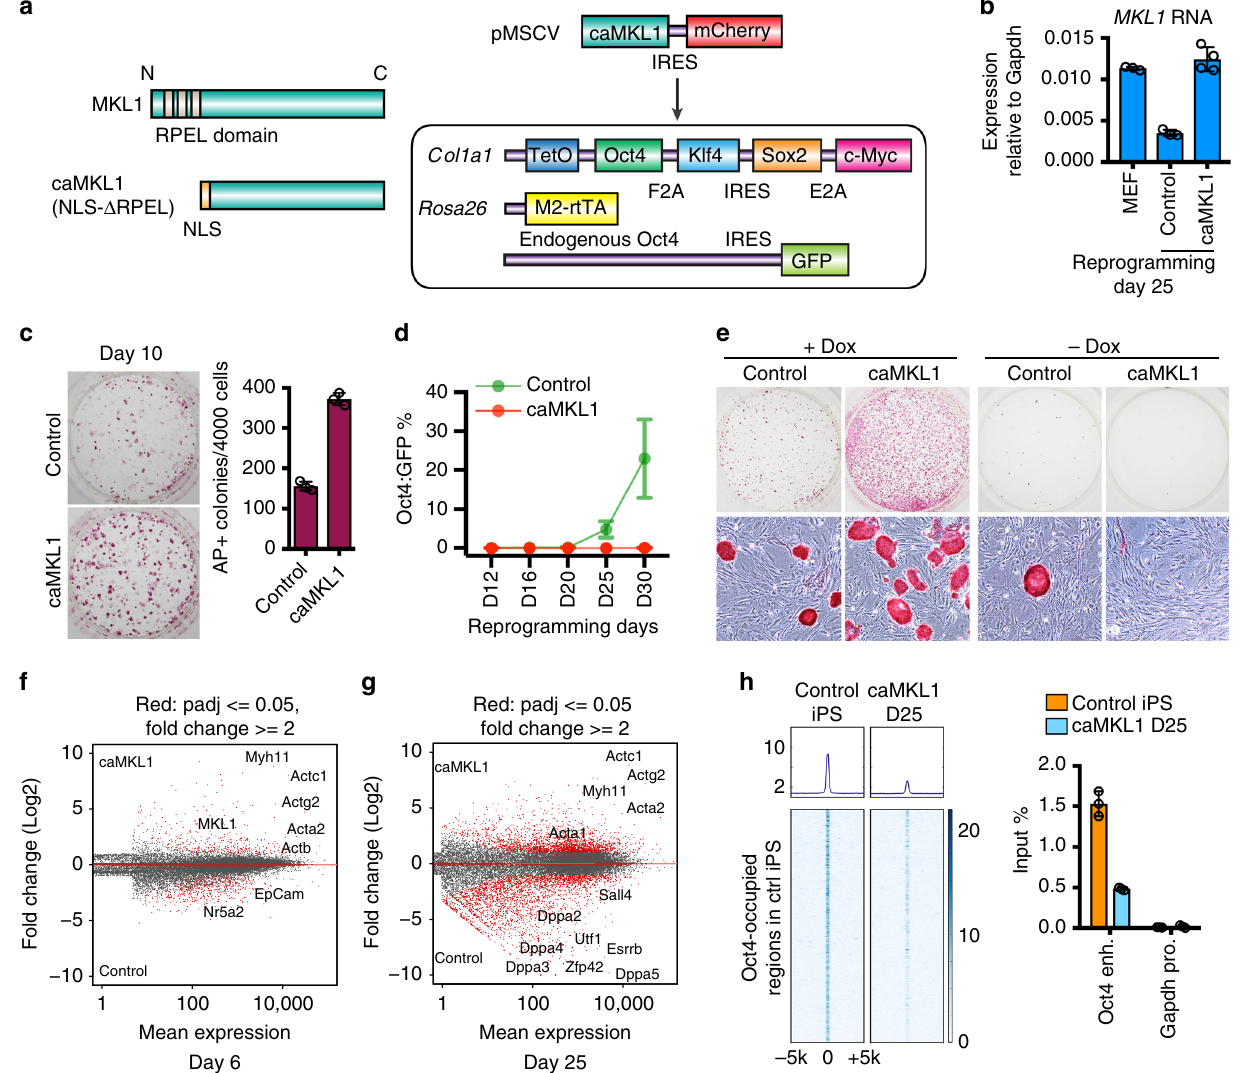
Fig. 2 MKL1 drives actin cytoskeletal gene expression and blocks mature pluripotency. a Left: schematic diagram of constitutively active MKL1 (caMKL1), with the RPEL domain deleted and replaced with a nuclear localization signal (NLS). Right: experimental design illustrating a retroviral vector expressing caMKL1-IRES-mCherry to be transduced into reprogrammable MEFs, which express Col1a:OKSM, Rosa26:M2rtTA and Oct4:GFP . The co-expressed mCherry from the vector was used to isolate the transduced cells for all further experiments. b Realtime QPCR analysis of total MKL1 mRNA level in primary MEFs, as compared to the cells at reprogramming day 25 coexpressing either a control vector or caMKL1. n = 3 for MEF and control; n = 4 for caMKL1- overexpressing condition. Error bars denote standard deviation. c AP stained reprogramming cultures on day 10, coexpressing either control vector or caMKL1. The number of AP + colonies derived from 4,000 reprogrammable MEFs are quanti fi ed. d Percentage of Oct4:GFP + cells arising from reprogramming MEFs coexpressing control vector or caMKL1, as determined by FACS. Cells were trypsinized and analyzed at indicated time points starting from day 10. e AP stained reprogramming cultures from control- or caMKL1-expressing reprogramming MEFs on day25, when cells were passaged and replated into continued cultures with or without Dox. Bottom panel shows colonies at higher magni fi cation. Note that no AP + colonies could be detected in the caMKL1-expressing cultures without Dox. f , g MA plots of differentially expressed genes between control- and caMKL1-overexpressing cells at reprogramming day 6 ( f ) and day 25 ( g ), respectively. h Meta analysis of Oct4-bound regions in day 25 reprogramming cells expressing the control vector or caMKL1 (left). The Oct4-bound regions in control iPS cells show reduced Oct4 binding in caMKL1-expressing cells. Oct4 ChIP-qPCR con fi rmed reduced binding at the Oct4 enhancer region in caMKL1-blocked cells (right). Error bars denote standard deviation of triplicate samples ( n = 3) in each one of